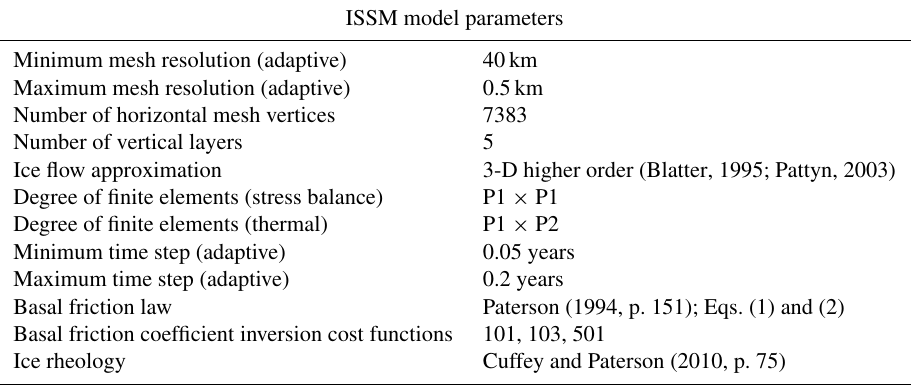
Table 1. ISSM model